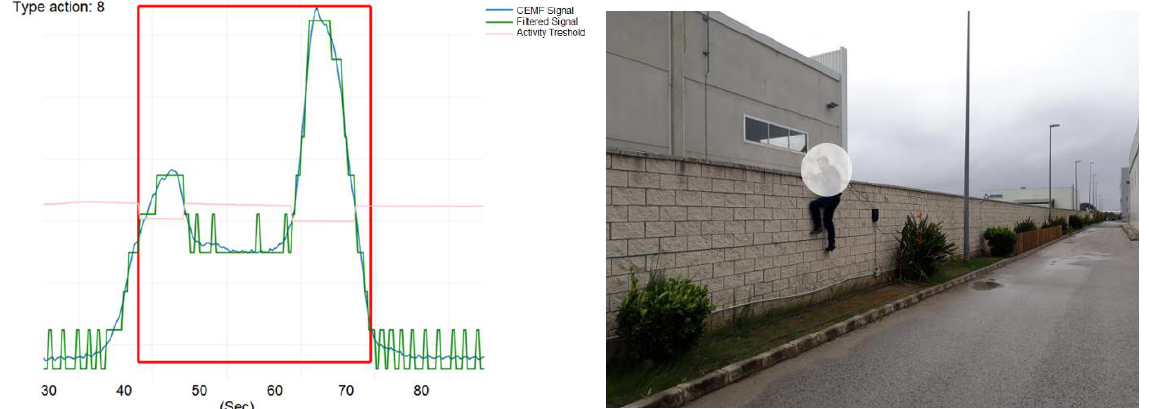
Figure 28. Validation events on the field. These images are precisely labeled with sensor ID, CEMF channel and timestamped. This fact allows for a manual cross-verification using the video system to validate the cause of the event.